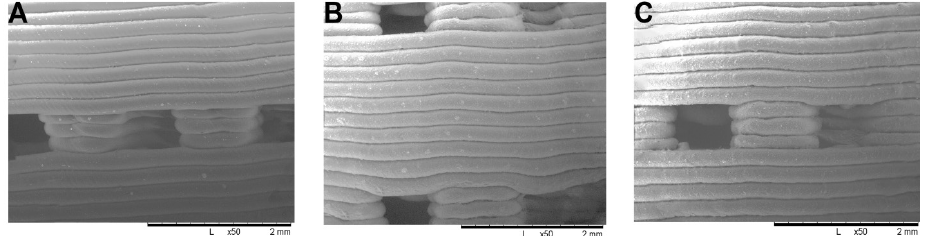
Figure 5. Structure of 3D printed PLA-based scaffolds: PLA ( A ); PLA/HAp ( B ); PLA/Wol ( C ), magnification ×50. nification ×